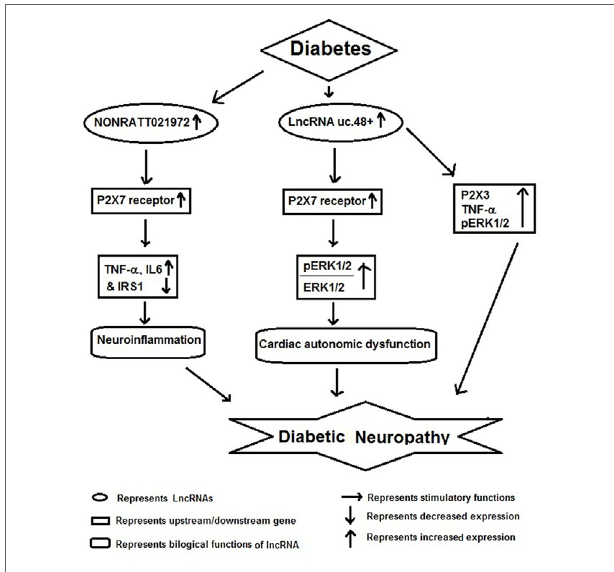
FiGURe 3 | Schematic model showing functional role of long non-coding RNAs (lncRNAs) in diabetic